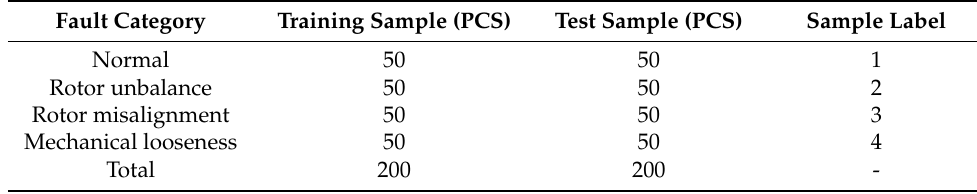
Table 4. Fault sample database classification and label configuration.